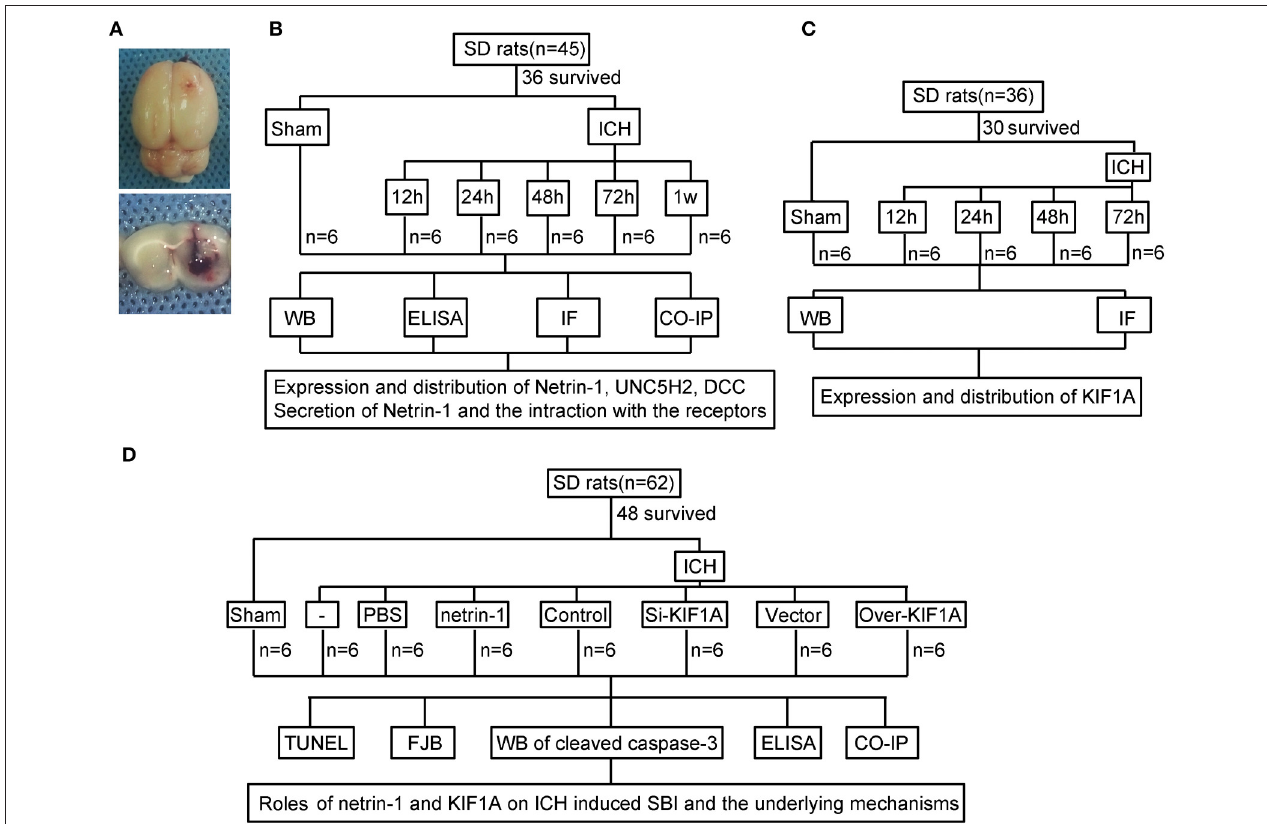
FIGURE 1 | Experimental design. (A) Representative gross brain morphology and representative coronal slices of the rat ICH model. (B) Experimental design to evaluate expression, secretion, and localization of netrin-1, expression and localization of DCC and UNC5H2, and interactions between ligand and receptors following ICH. (C) Experiment designed to investigate changes in levels of motor protein, KIF1A, after ICH. (D) Experiment designed to elucidate the roles of netrin-1 and KIF1A in ICH-induced SBI and potential